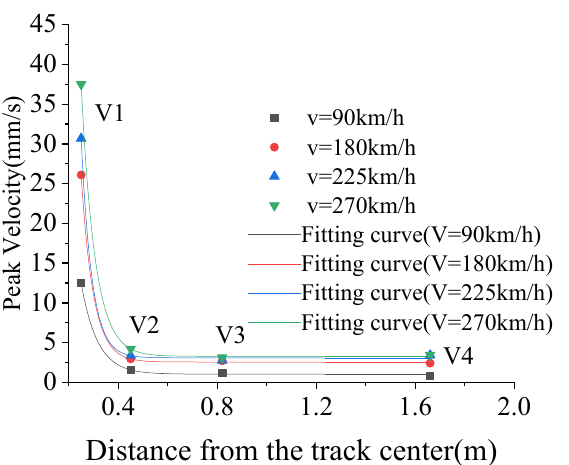
Figure 13. Distribution of the vibration velocity in the horizontal direction from the track center.